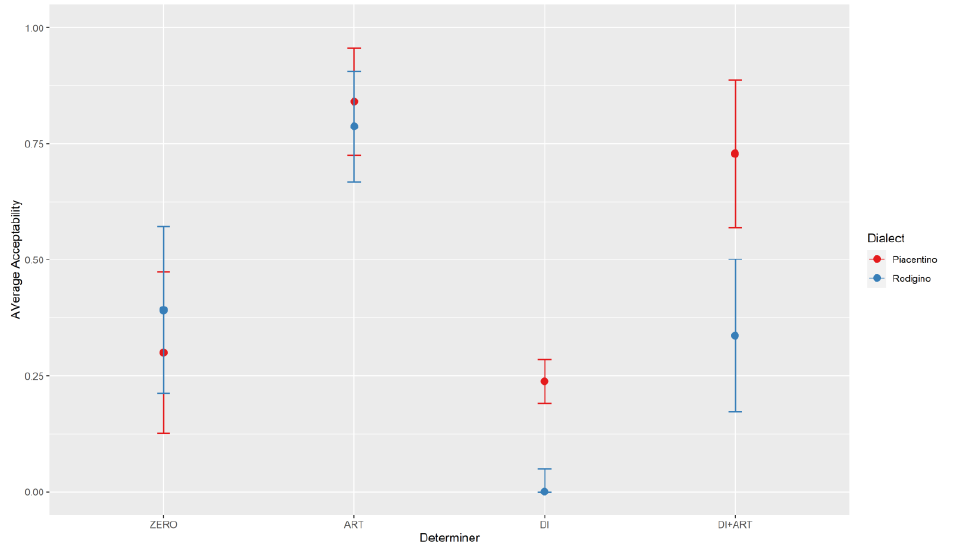
Figure 6. Average acceptability scores by determiner type and speaker’s dialect. For the sake of brevity and to avoid redundancy, only the acceptability scores from the by-subject analysis are